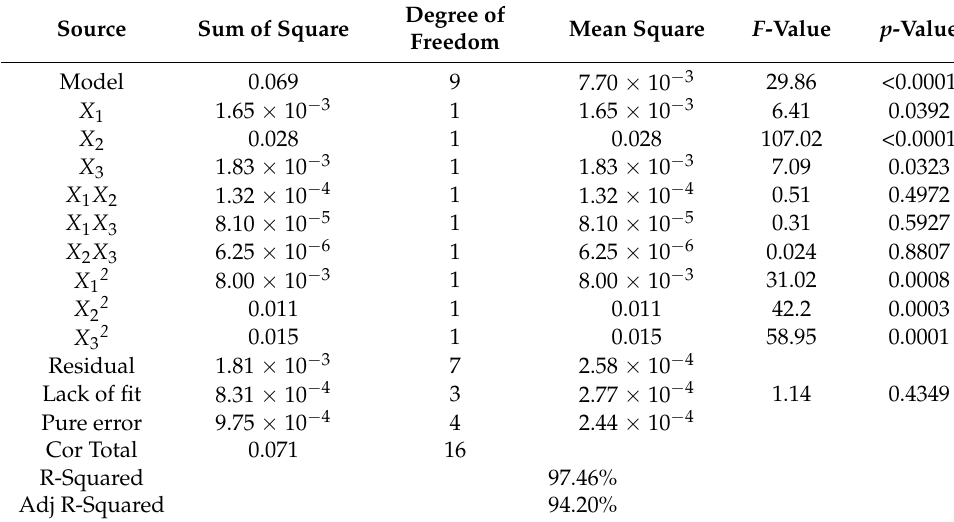
Degree of Mean Square F -Value p -Value Freedom